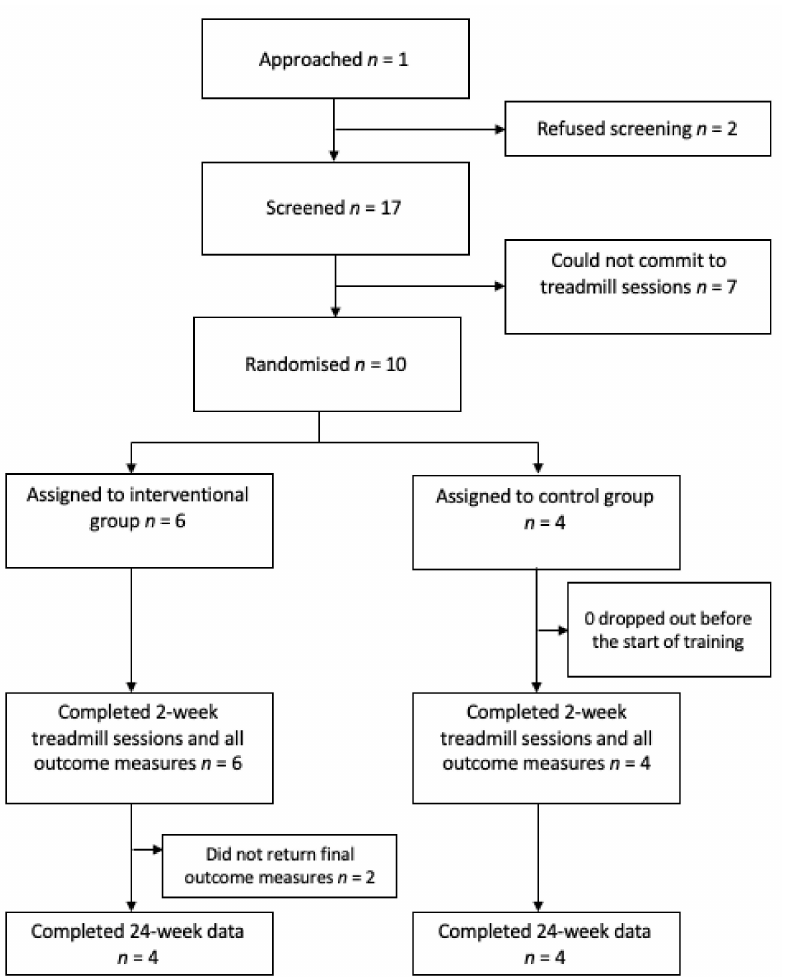
Figure 2. Flowchart of Virtual Environment Rehabilitation for Patients with Motor Neglect Trial (VERMONT)